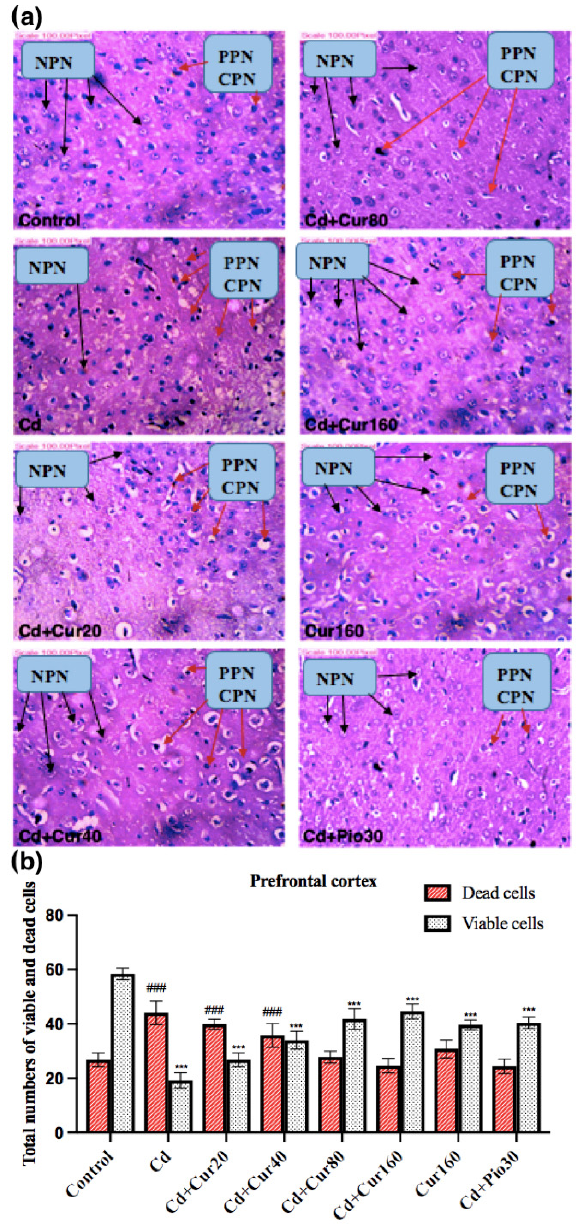
Figure 7. Effect of curcumin on cadmium exposed animals’ prefrontal cortex brain region. ( a ) In the Cd exposed groups, more pyknotic prefrontal neurons (PPN) and chromatolysis prefrontal neurons (CPN) were seen in the prefrontal cortex region (red arrows). Curcumin treatment had significantly increased the normal prefrontal neurons (NPN) (black arrows). ( b ) The total number of viable and dead neurons in the prefrontal cortex region of different groups of mice. *** p < 0.001 showing significant differences of viable cells between control and treatment group. ### p < 0.001 and showing significant differences of dead cells between Cd exposed group and curcumin treated groups.